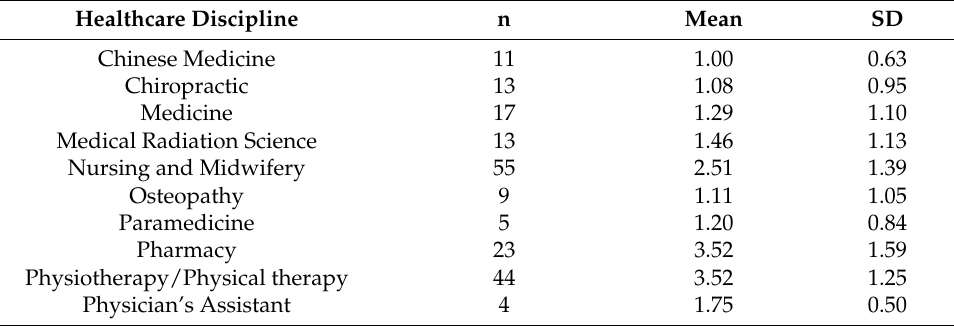
Table 4. Mean anatomical knowledge of specific healthcare disciplines.